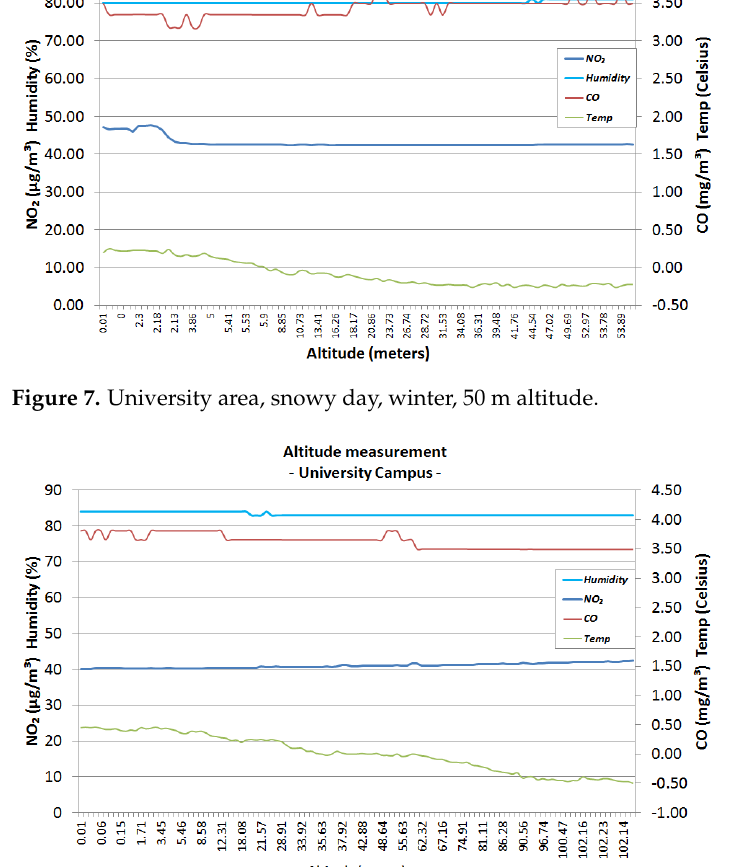
Figure 8. University area, snowy day, winter, 100 m altitude.